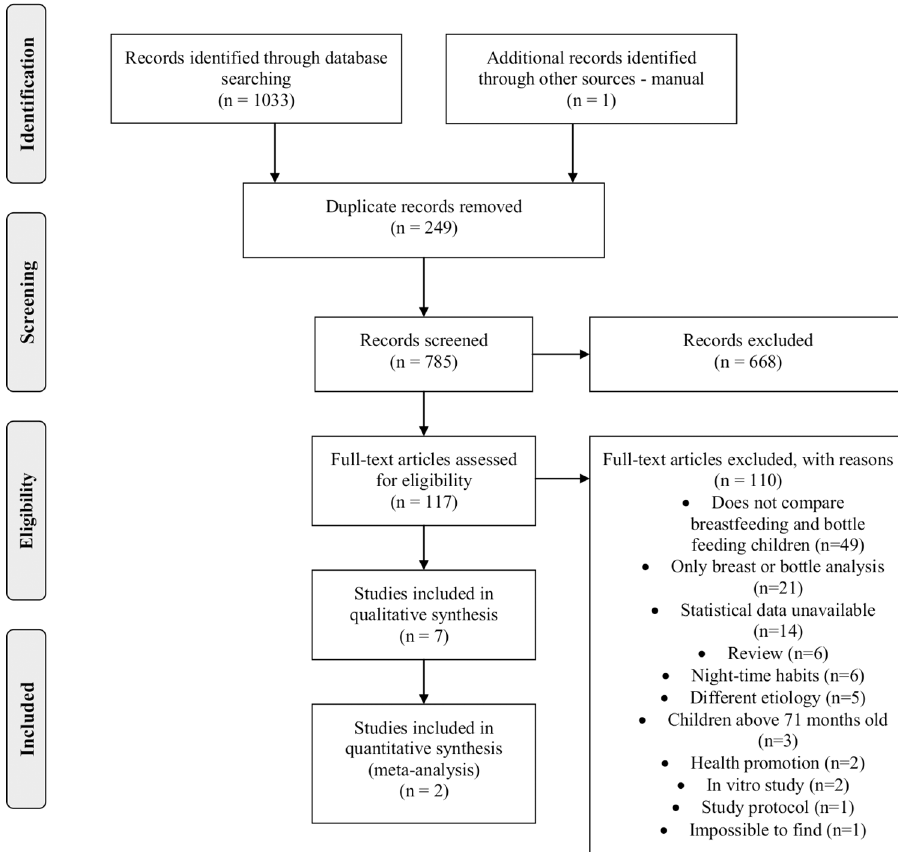
Fig 1. Screening of articles. Four-phase PRISMA flow-diagram for study collection, showing number of studies identified, screened, eligible, included in review and meta-analysis [26].